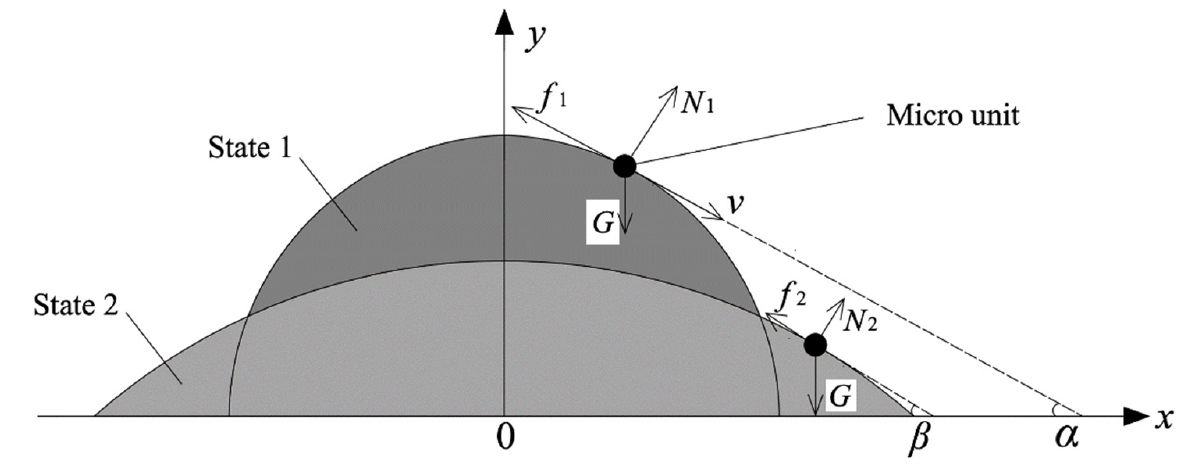
Figure 3. Stress state of micro-unit of mixture in slump process.